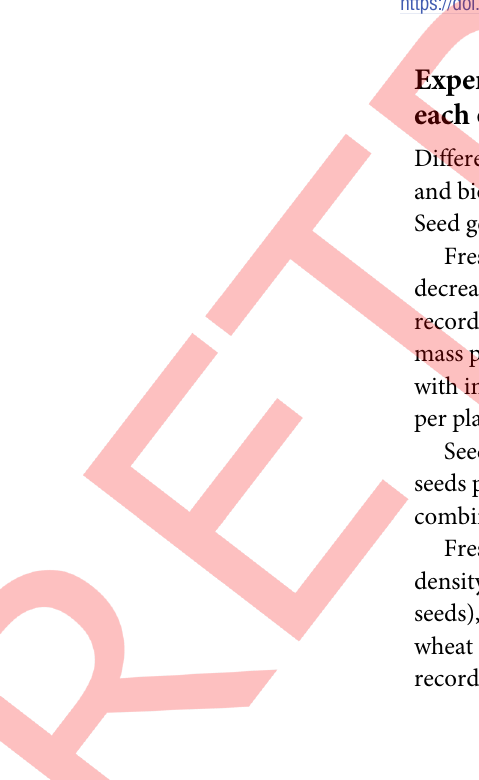
Fig 1. The effect of different constant temperature regimes on days to start emergence (A), seed germination percentage (B), seedling fresh weight (C) and seedling dry weight (D) of wild oat.